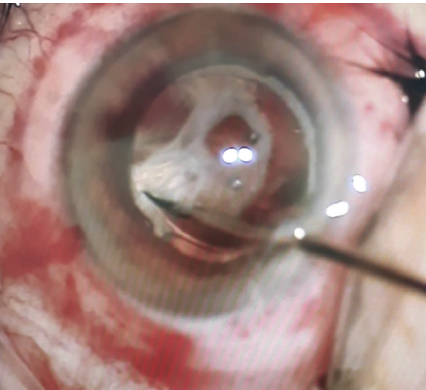
Figure 3: Intraoperative image of residual fibrotic tissue removal using 23-gauge vitreal microscissors following femtosecond laser